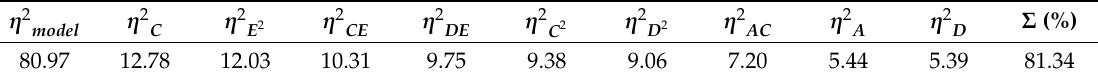
Table 8. The proportion of total variance explained by the certain experimental e ff ect. η 2